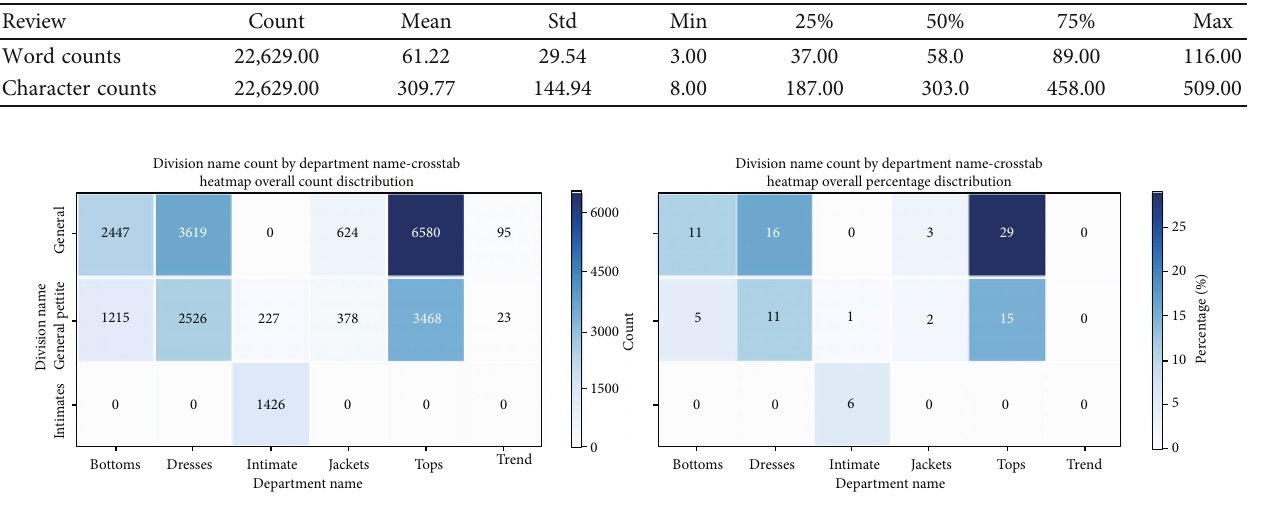
Figure 7: The cross-tab demonstrates the superiority of the general-sized